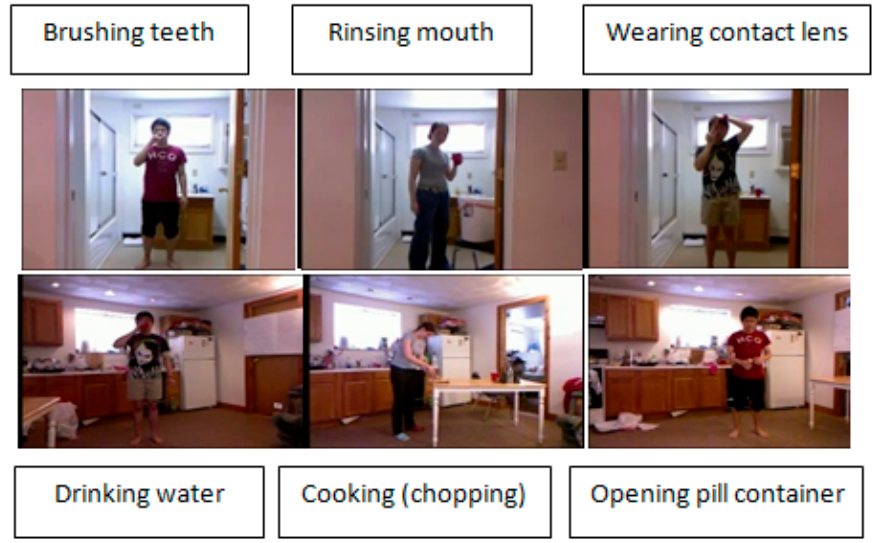
Figure 6. Six activity classes included in the CAD-60 dataset. The video samples were captured by Microsoft Kinect sensors concurrently at 25 fps. The activities were performed in the bathroom and kitchen.